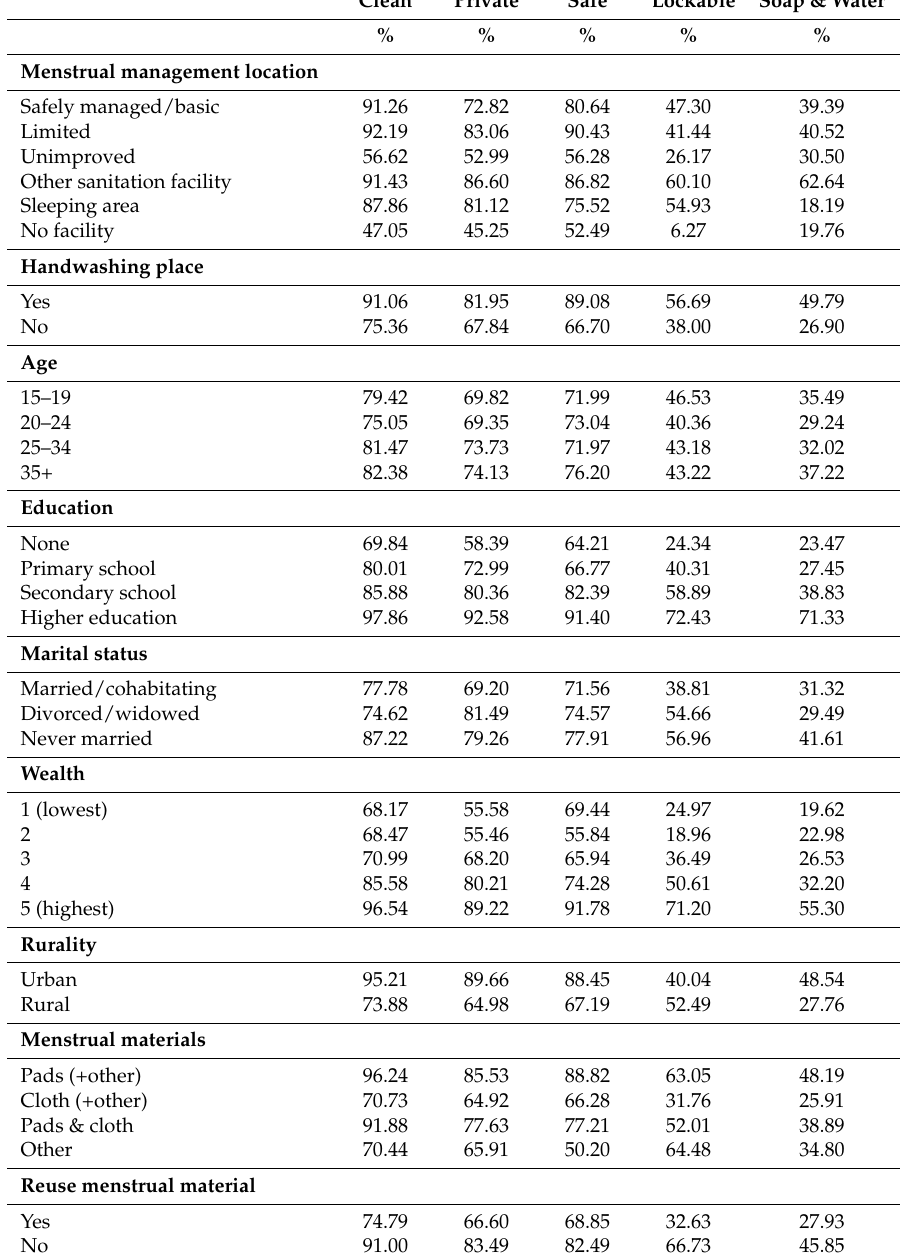
Table 4. Proportion of women describing their menstrual management location as clean, private, safe, lockable and having access to soap and water, according to household sanitation, water, and